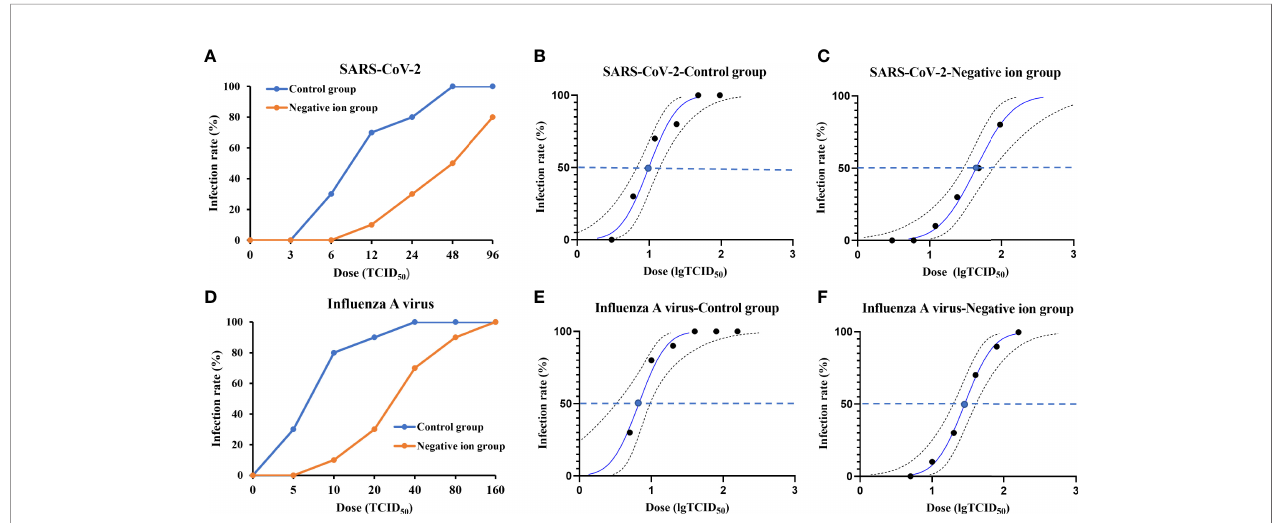
FIGURE 5 | Infectionrateand50%infectivedose(ID 50 ) plotsfor animals exposedtoaerosolizedvirus.Theinfectionrateofanimals exposedtoaerosolizedsevereacute respiratorysyndrome coronavirus 2(SARS-CoV-2) (A) or in fl uenzaA virus (D) whenthe ionizerwas activeor inactivewasdetermined.Panels (B,C, E,F) show theprobitanalysis todetermineID 50 for aerosolizedSARS-CoV-2or in fl uenzaA virusexposurewhentheionizer wasactiveorinactive. Dashedlinesshow 95%con fi denceintervalfor the analysis.